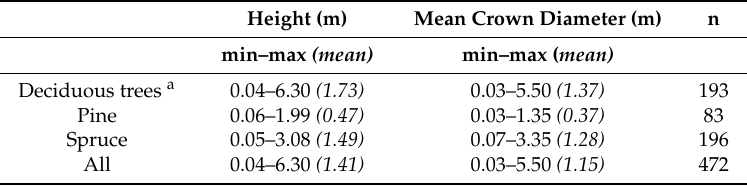
Table 1. Summary of the field-measured